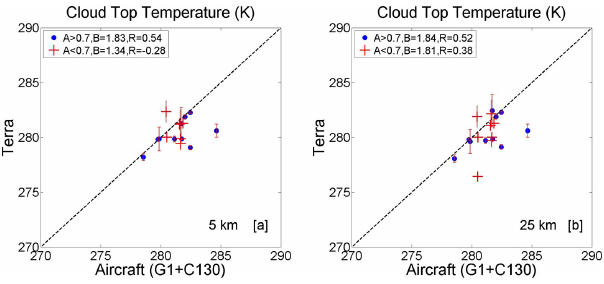
Fig. 9. Comparison of retrieved cloud top temperature from MODIS with the in-situ measurements: the dashed-lines are for the 1:1 lines.